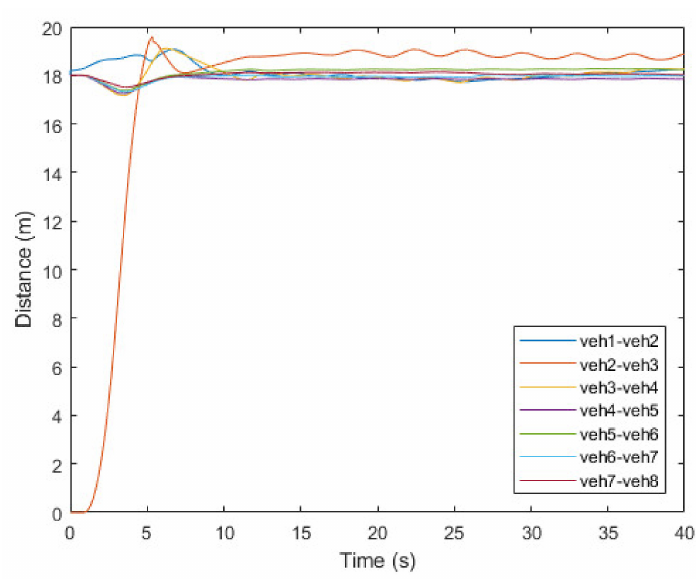
Figure 9. Inter vehicle distance of